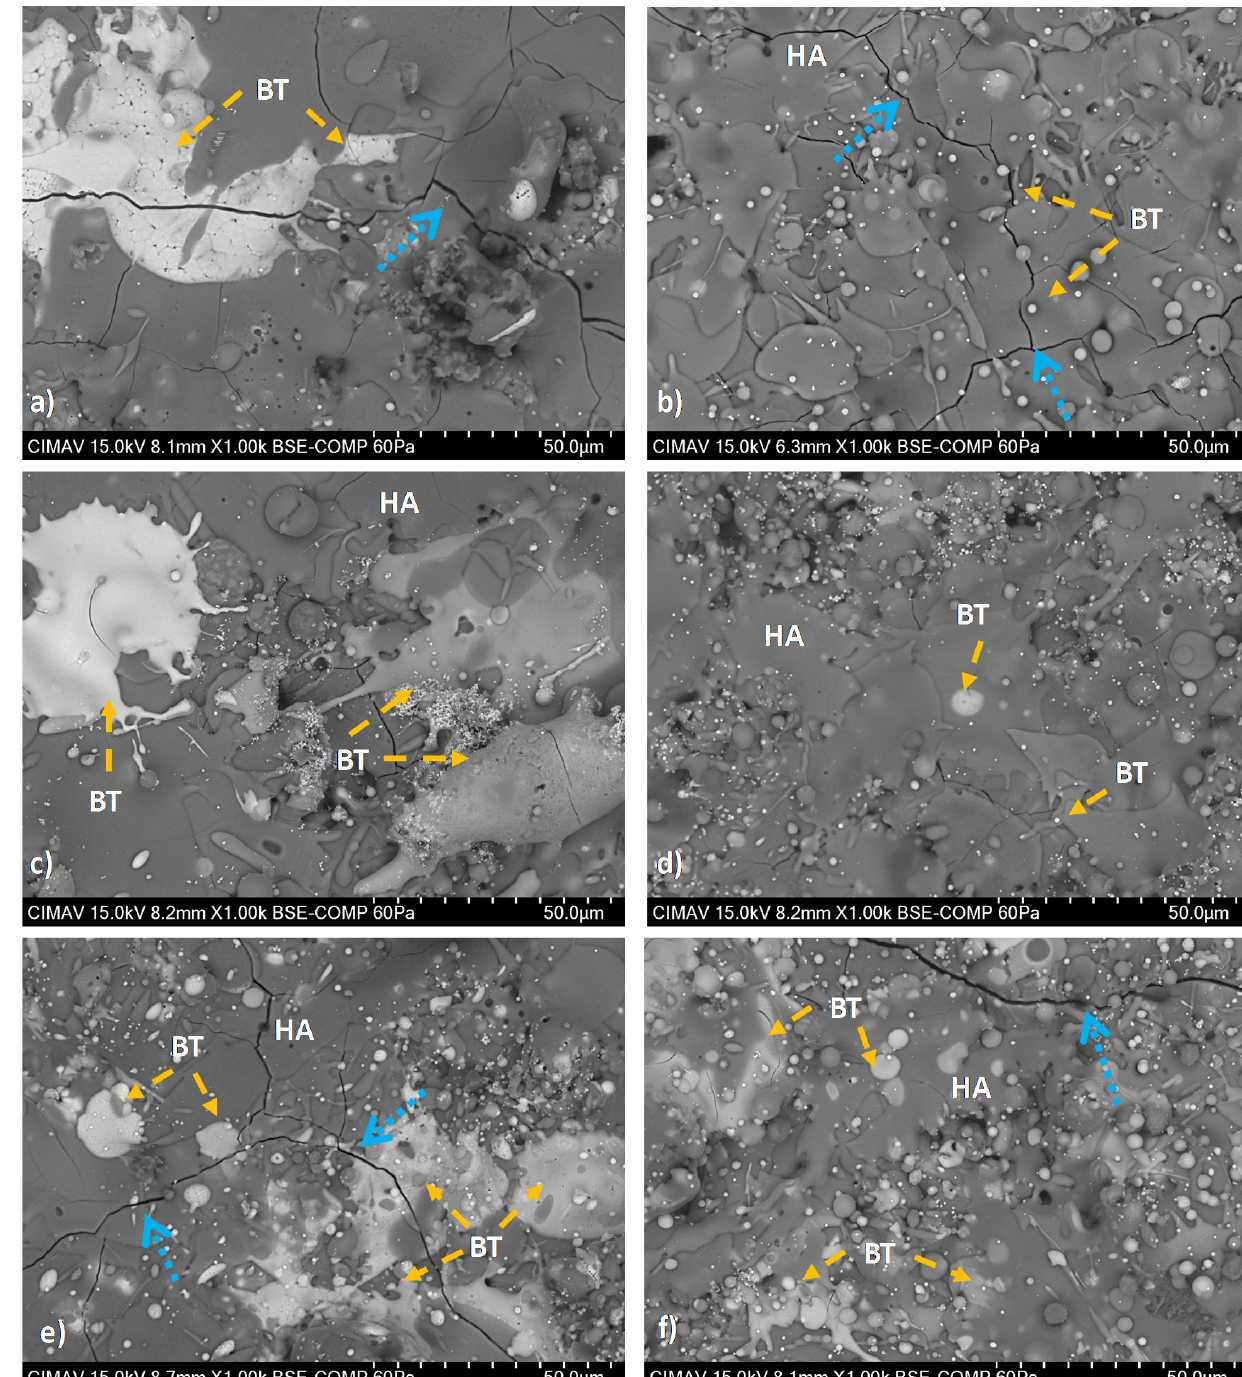
Figure 6. Superficial BSE micrographs of coatings developed with; (i) MSH: ( a ) HA10BT S, ( c ) HA30BT S, and ( e ) HA50BT S; and (ii) HEBM: ( b ) HA10BT BM, ( d ) HA30BT BM, and ( f ) HA50BT BM. According to the BSE image signal acquisition the BT phase shows in white regions (identify in orange arrows) and HA as a continuous phase was in the gray zones. The typically fractures of the coating due to high temperature reached during the APS deposition and rapid cooling marked in blue arrows.